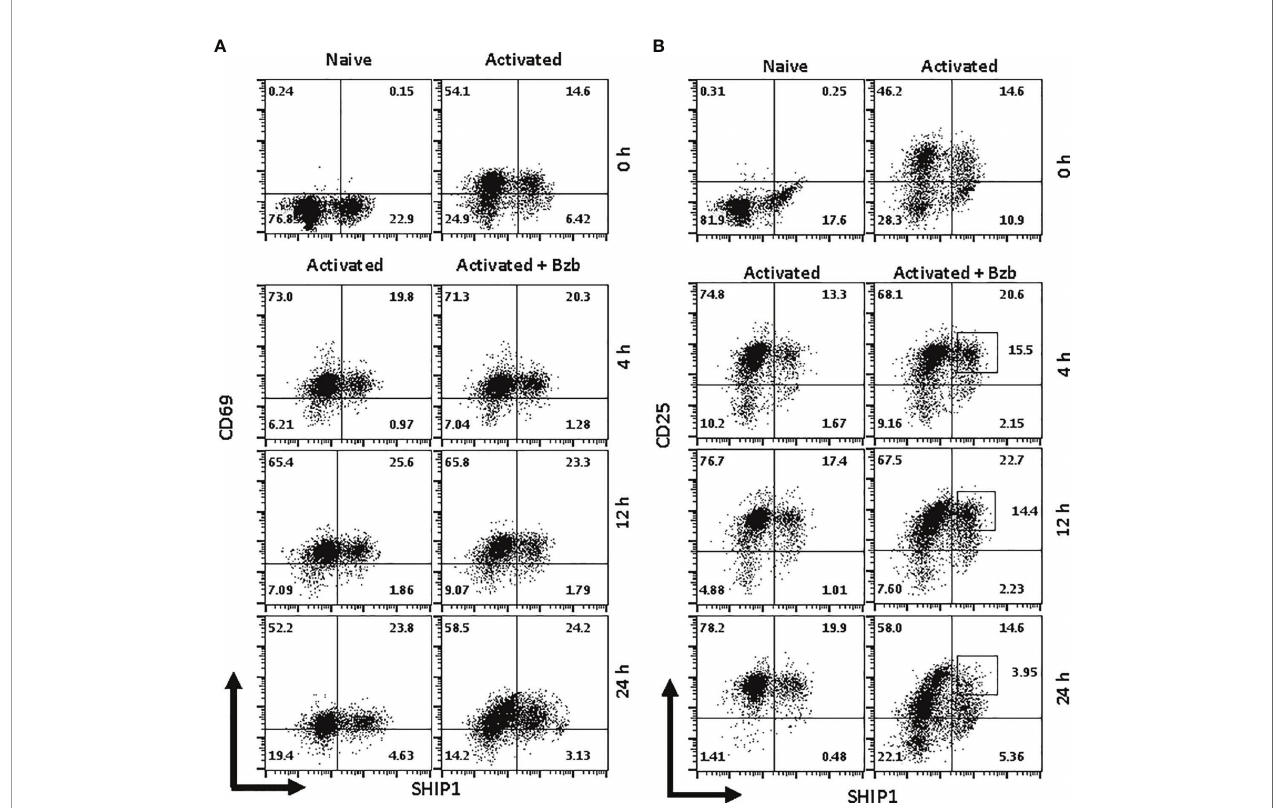
FIGURE 9 | Bortezomib decreases SH-2 containing inositol 5 ’ -polyphosphatase 1 (SHIP1) protein levels in activated CD8 + T cells. CD8 + T cells were puri fi ed from the spleen and lymph nodes of naïve BALB/c wild-type (WT) mice. Cells were stimulated in vitro with soluble anti-mouse CD3 and CD28 antibodies (1 µg/ml each) for ~20 h followed by treatment with 10 nM bortezomib for 4, 12, and 24 h. With each time point, surface staining for CD8, CD69, and CD25 as well as intracellular staining for suppressor of cytokine signaling 1 (SOCS1) and SHIP1 was performed. Representative dot plots depict percentages of CD8 + cells that express both SHIP1 and CD69 (A) or SHIP1 and CD25 (B) in the naïve, activated, and activated plus bortezomib-treated